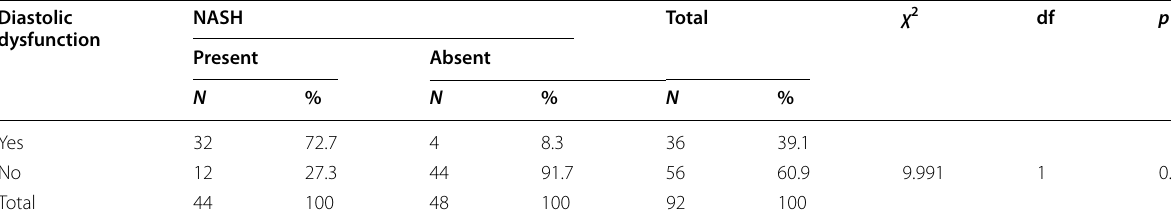
Table 2 Diastolic dysfunction among NASH and NAFL Diastolic